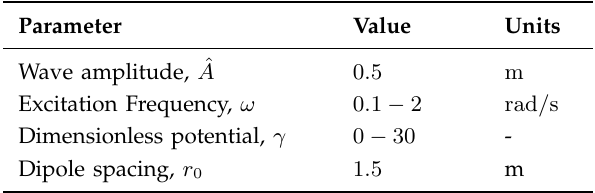
TABLE III S IMULATION PARAMETERS FOR THE 1-DOF AND 3-DOF